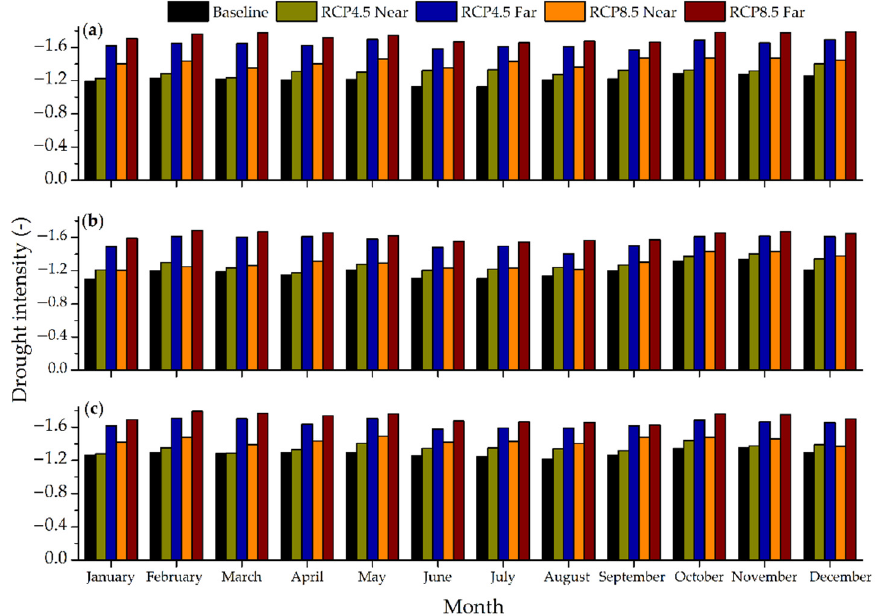
Figure 18. Average drought intensities: ( a ) SPI; ( b ) SDI; and ( c ) RDI for the baseline and future pe- riods.